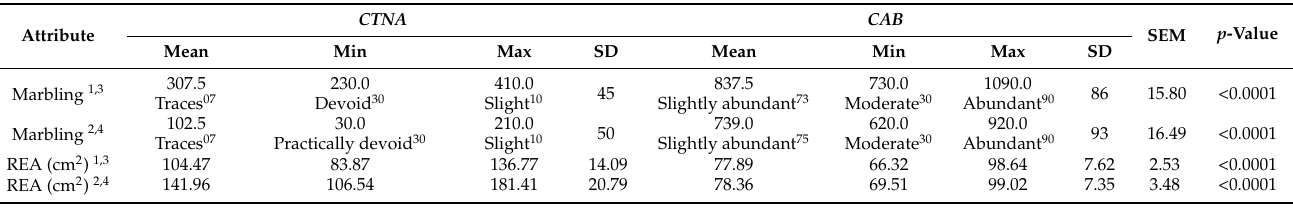
Table 1. Descriptive statistics and mean comparison for degree of marbling and Longissimus dorsi thoracis eye area (REA) according to EU classification and USDA grading systems for carcasses derived from bullocks PGI-Certified Ternera de Navarra ( CTNA ) and Certified Angus Beef ( CAB ) steers, respectively.